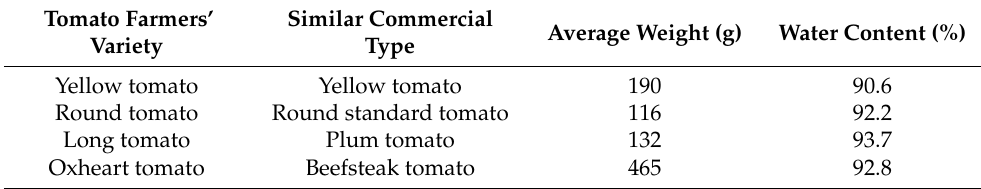
Table 1. Moisture content and average weight of the tomato farmers’